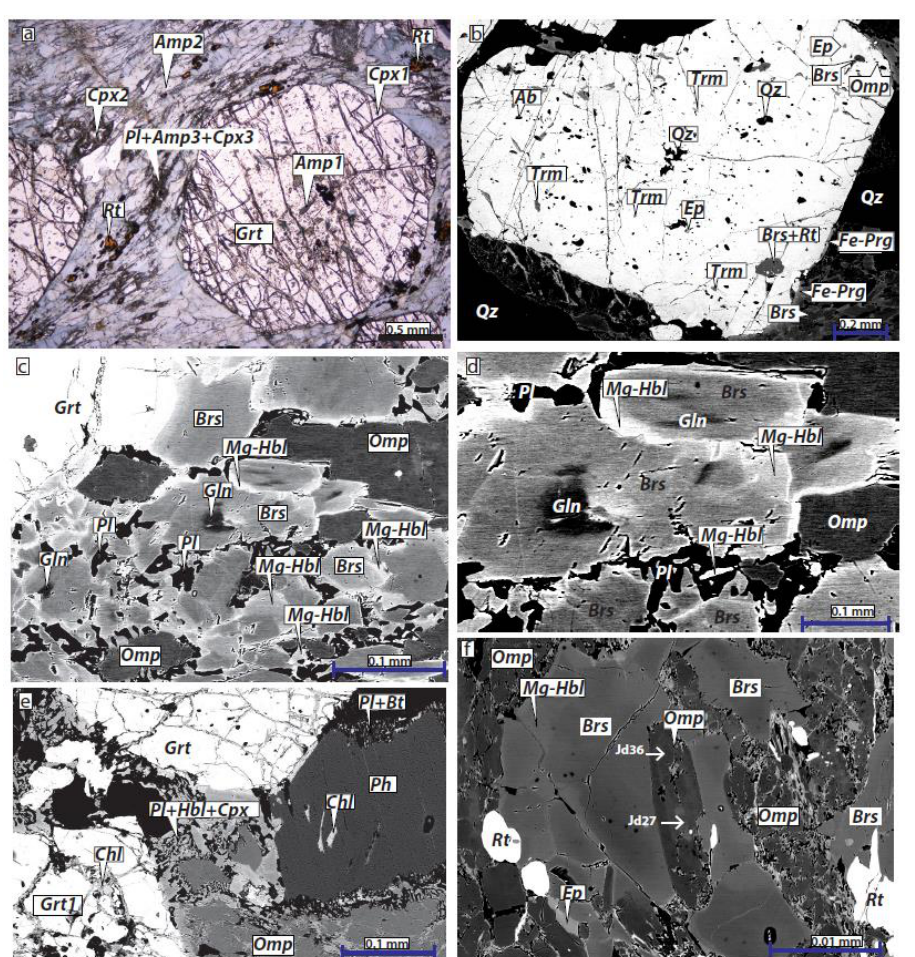
Figure 4. and backscattered electron image (BEI) images of eclogites from the Alag Khadny metamorphic complex. ( a ) Photomicrograph of eclogite (MG802). Mineral assemblage of garnet (Grt1), omphacite (Cpx2) barroisite (Amp2) and rutile in the matrix. Omphacties replaced